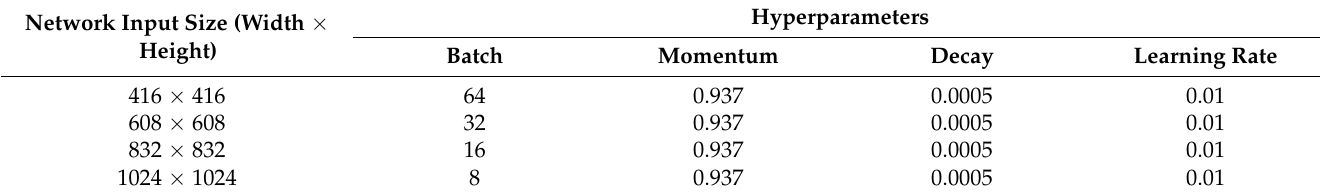
Table 5. YOLOv5m network input sizes and hyperparameters scenario for training and